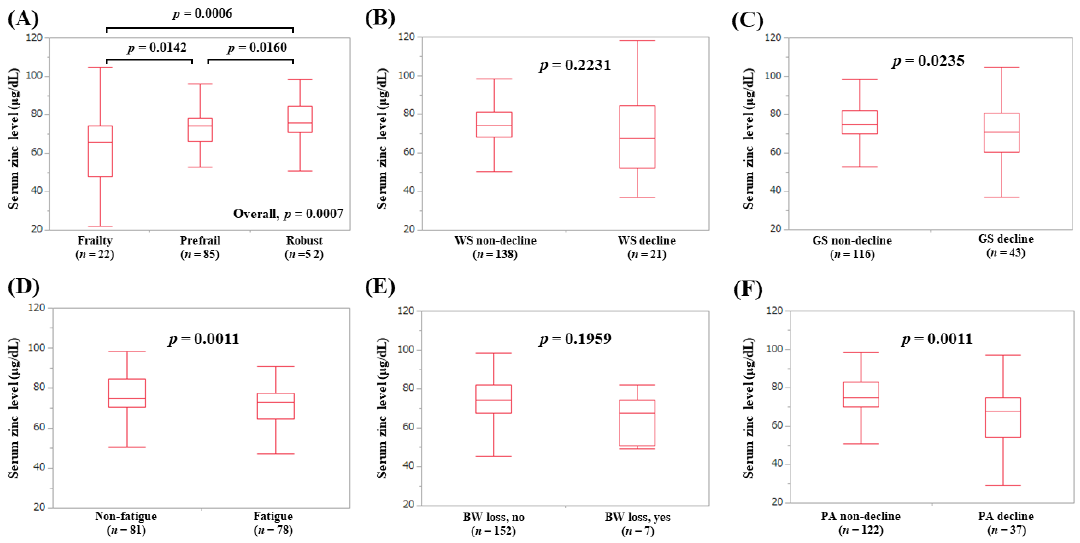
Figure 8. Serum Zn level according to the frailty status ( A ) and serum Zn level according to each frailty phenotype in male patients: ( B ) walking speed, ( C ) grip strength, ( D ) fatigue, ( E ) body weight loss, ( F ) physical activity.